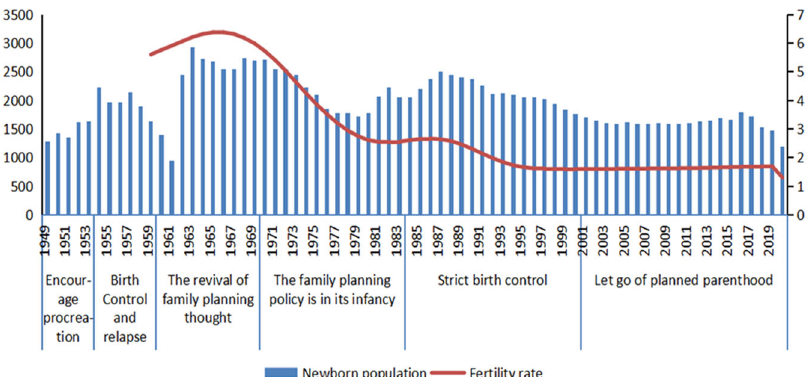
Fig. 1 China ’ s newborn population and fertility rate from 1949 to 2020. Newborn population and total fertility rate at each stage of China ’ s fertility policy (newborn population unit: 10,000).